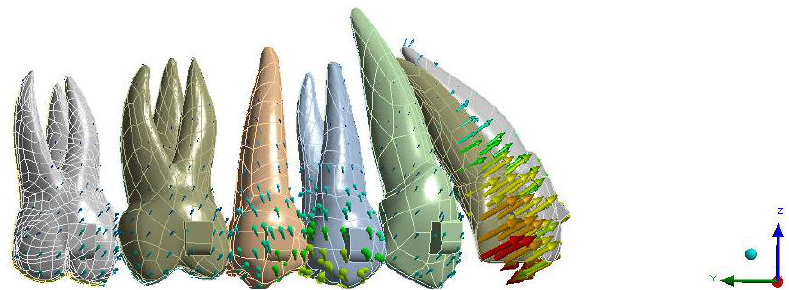
Figure 3. Amount of deformation based on the analyses of the OTT model.